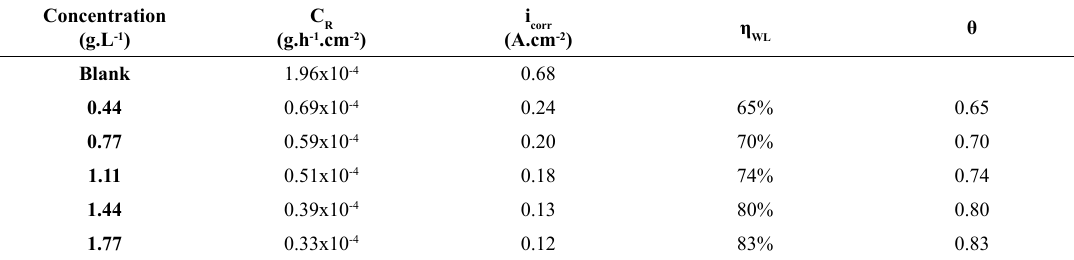
Table 1. Corrosion rate, corrosion current density, coverage degree and inhibitory efficiency calculated from gravimetric experiments for AISI 1020 carbon steel, after immersion during 120 min in 0.5 mol.L -1 HCl solution, in the absence and in the presence of different amounts of castor bark powder.